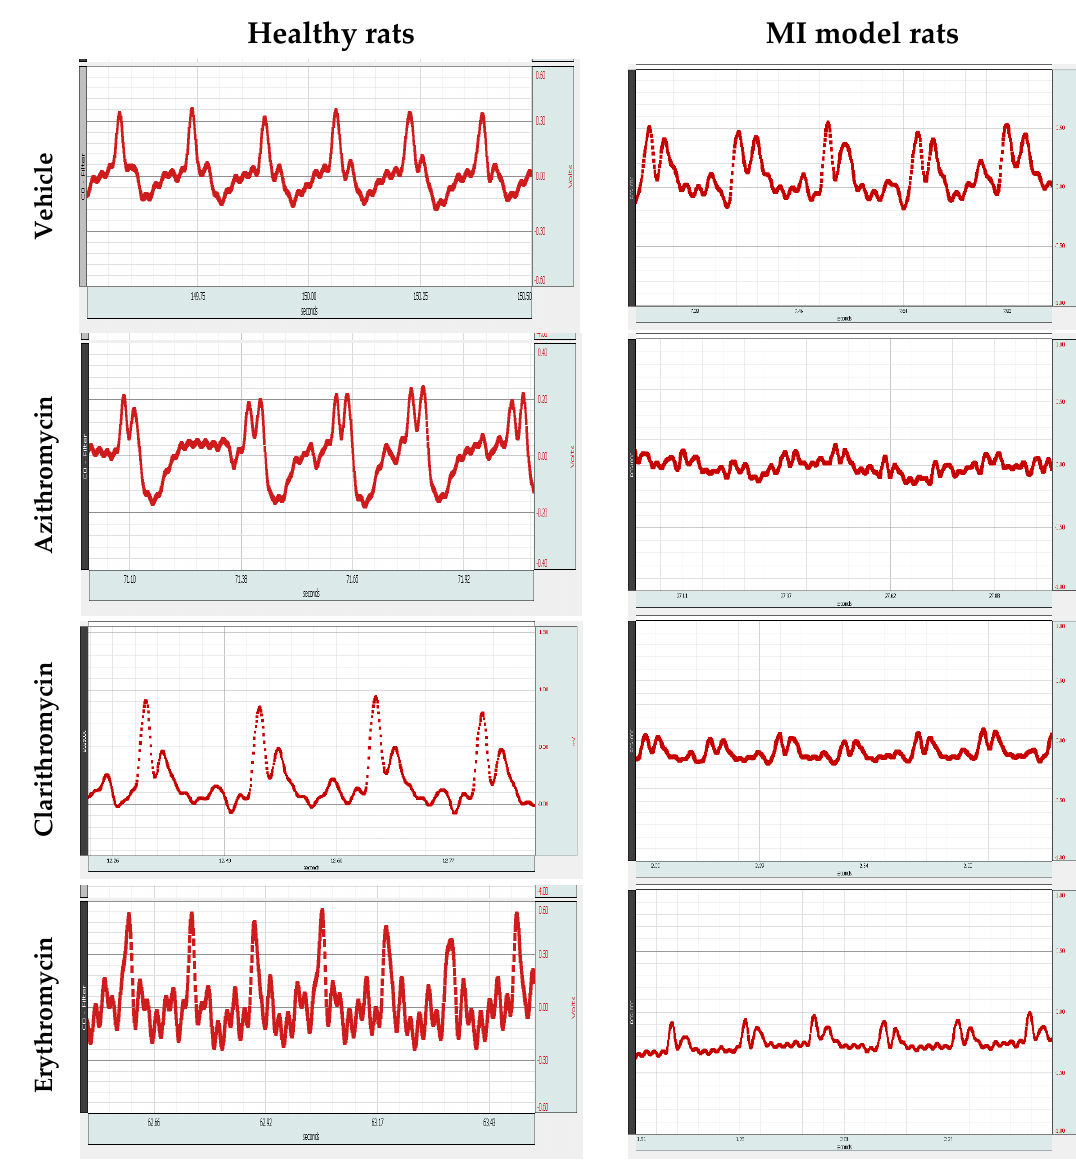
Figure 3. Electrocardiograms from healthy or myocardial infarction model rats treated with Azithromycin, Clarithromycin, and Erythromycin. Rats were subjected to ECG recording under ether anesthesia in the Biopac data acquisition mp150 device. The left side images for healthy rats treated with azithromycin, clarithromycin or erythromycin showing ST-segment elevation and QT prolongation. The right side images are ECGs from the myocardial infarction rat model experiment treated with azithromycin, clarithromycin or erythromycin.